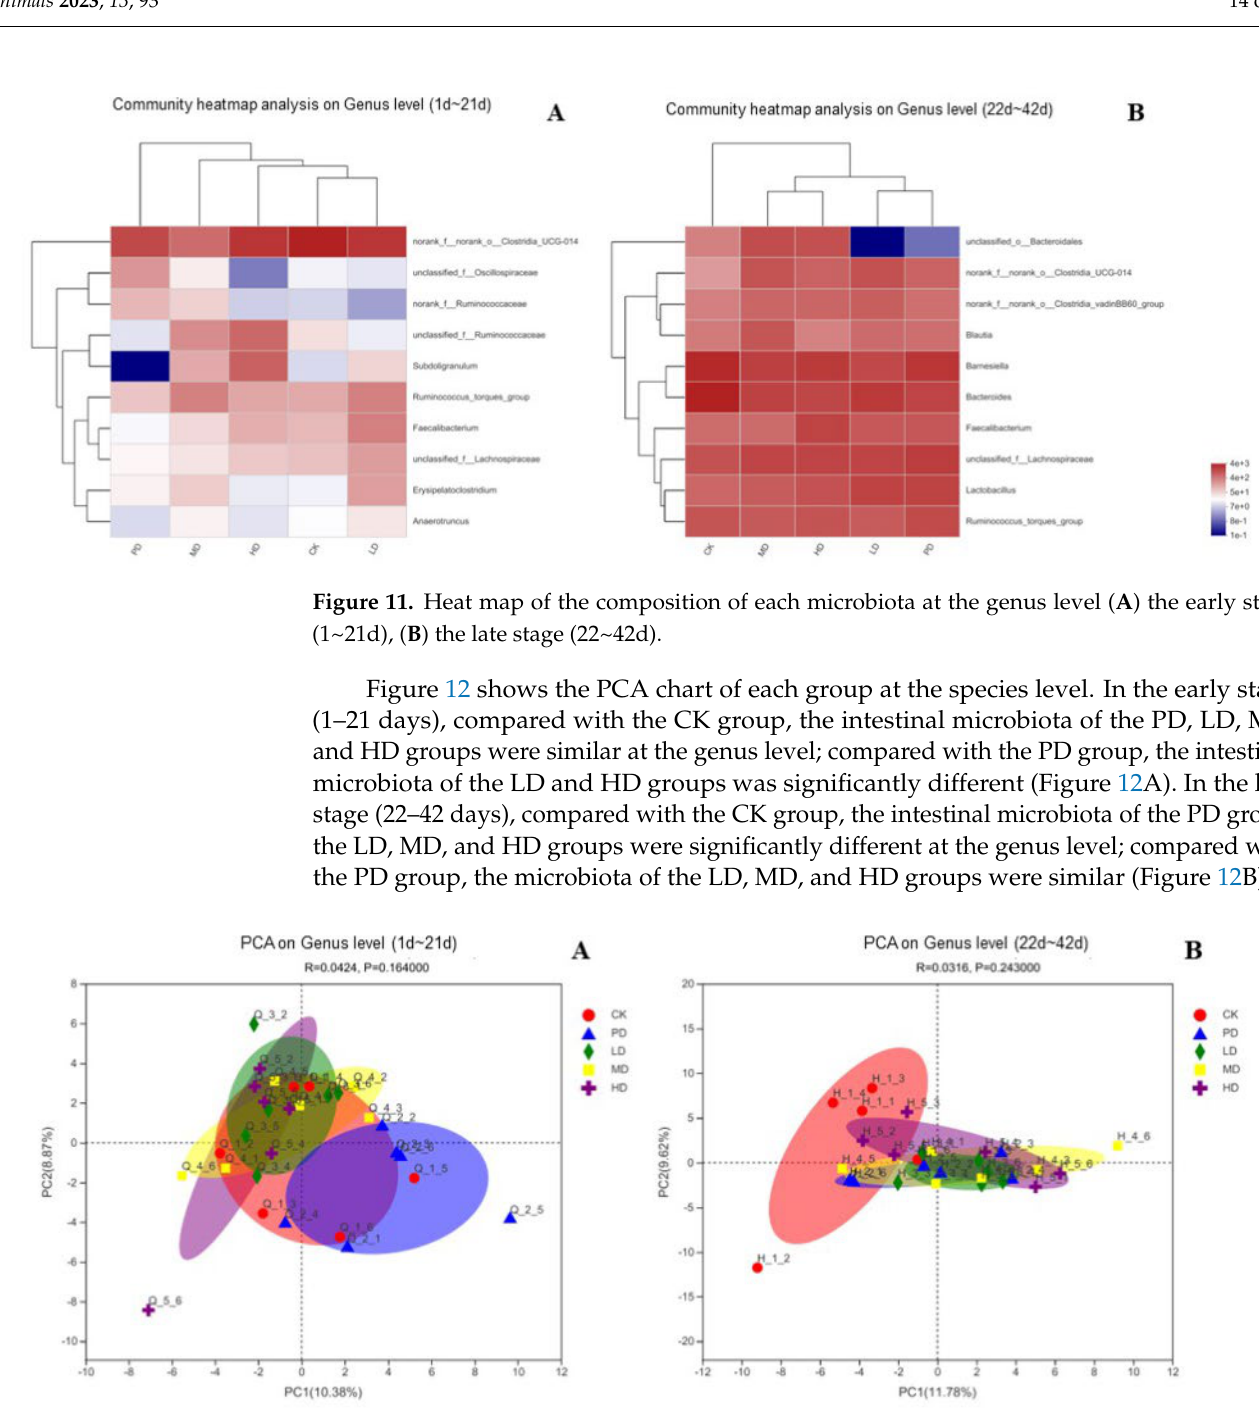
Figure 12. PCA analysis of each group at the genus level ( A ): the early stage (1~21d), ( B ): the late stage (22~42d).